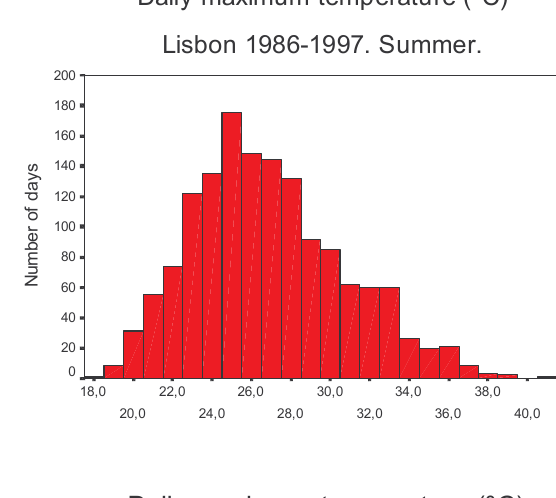
Figure 1a : Daily mortality anomalies (anomalies>0) versus daily maximum temperatures for Lisbon. The solid line corresponds to a minsce method with 50% of the points and 3 iterations adjustment. The corresponding 95 percentile Tmax value for Lisbon is also represented.